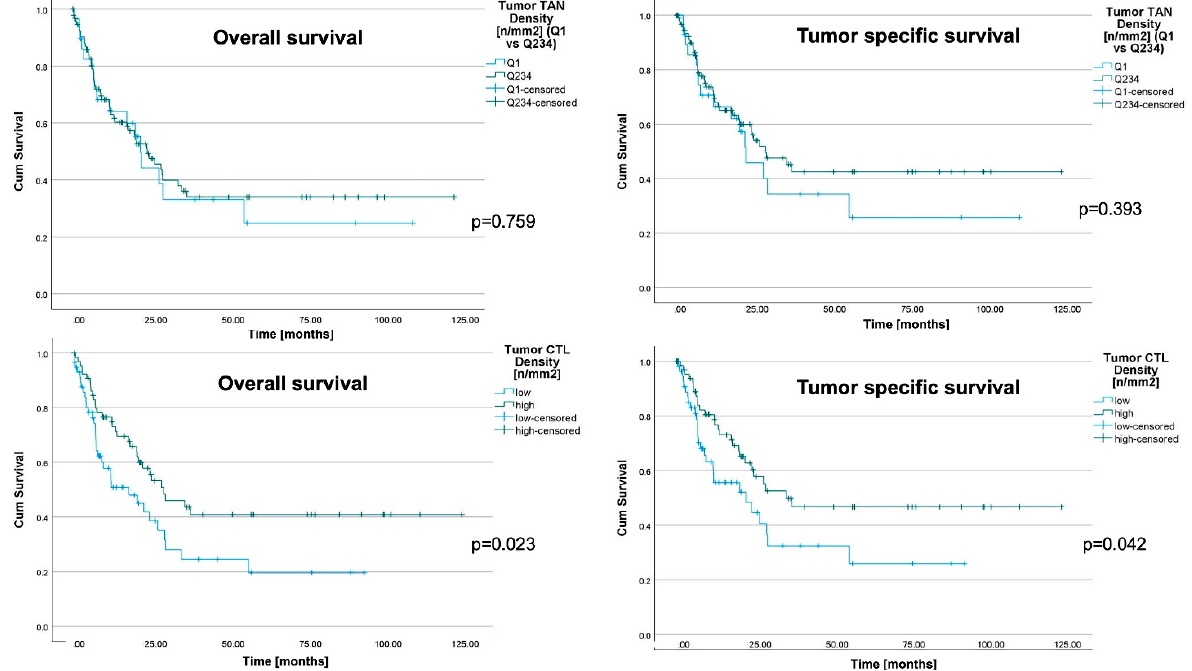
Figure 4. Patient survival. Kaplan–Meier curves of the whole cohort, depicting patients’ overall and tumor-specific survival, according to the densities of myeloperoxidase-immunoreactive tumor-associated neutrophils (TAN) in tumor center (dichotomized into quartile 1 vs. quartile 2–4) and densities of CD8+ cells (dichotomized into quartile 1 and 2 vs. quartile 3 and 4). All p -values shown in the graph were obtained by log-rank test. Patients with a higher cytotoxic T cell (CTL) density in the tumor center showed a significantly better overall and tumor specific survival. In contrast, the TAN density in the tumor center was not correlated with a better outcome.